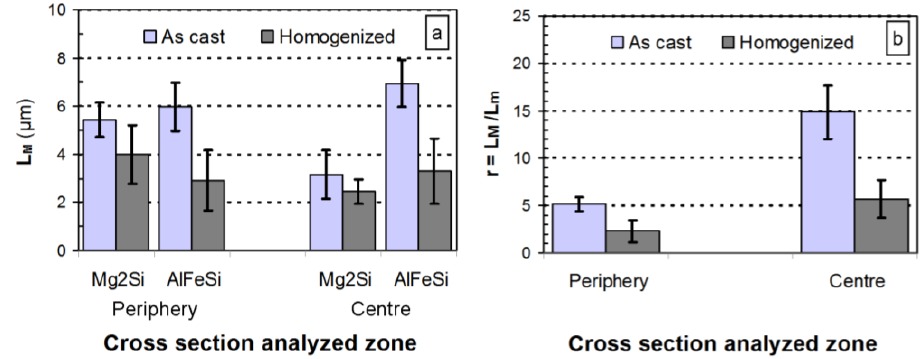
Figure 5. Particle morphology determinations assessed in selected zones of the billet cross section both in the as-cast state and after homogenizing. ( a ) Maximum Feret diameter, L for Mg Si and AlFeSi particles; and ( b ) shape ratio r = L 2 Error bars represent the 95% confidence limit of the